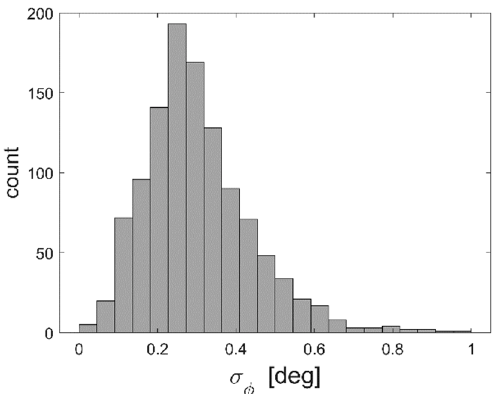
Figure 6. Histogram of standard deviations σ φ gauging the spread of angles φ j , m resulting from uncalibrated robot and multiple inverse kinematic solutions for data acquired in Experiment 2 with the motion capture system.